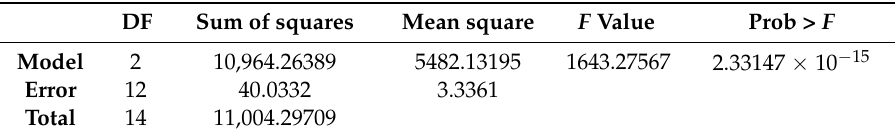
Table 4. Overall analysis of water absorption capacity.